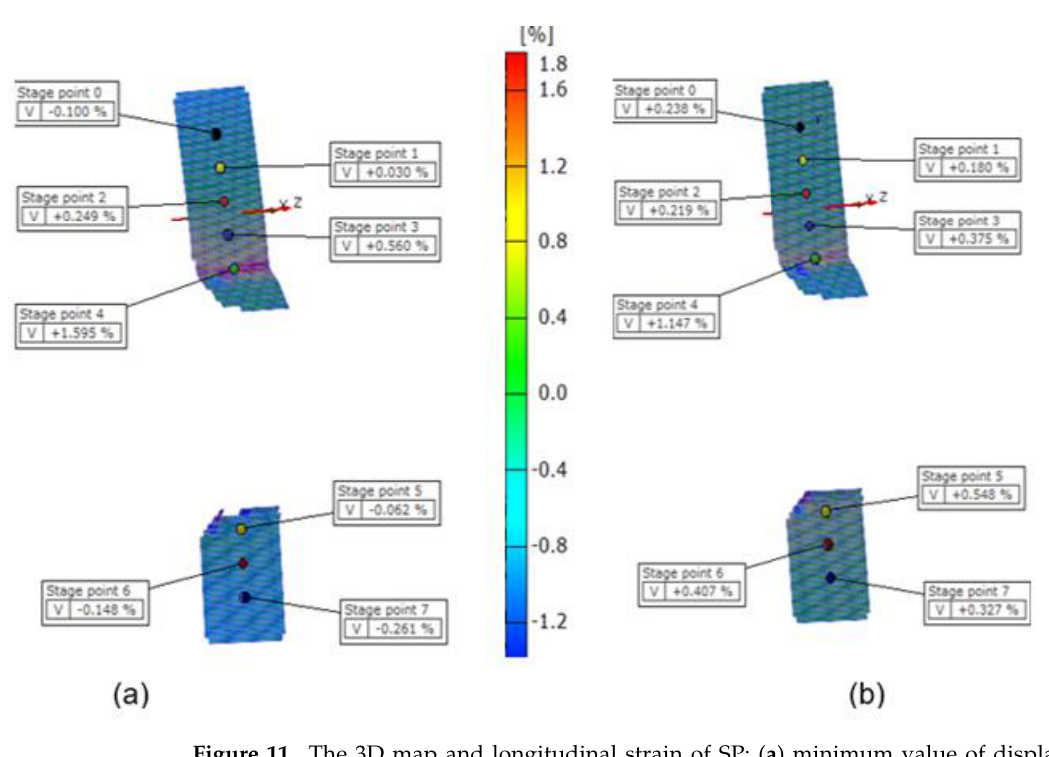
Figure 11. The 3D map and longitudinal strain of SP: ( a ) minimum value of displacement and ( b ) maximum value of displacement; (da = 0.45 mm).